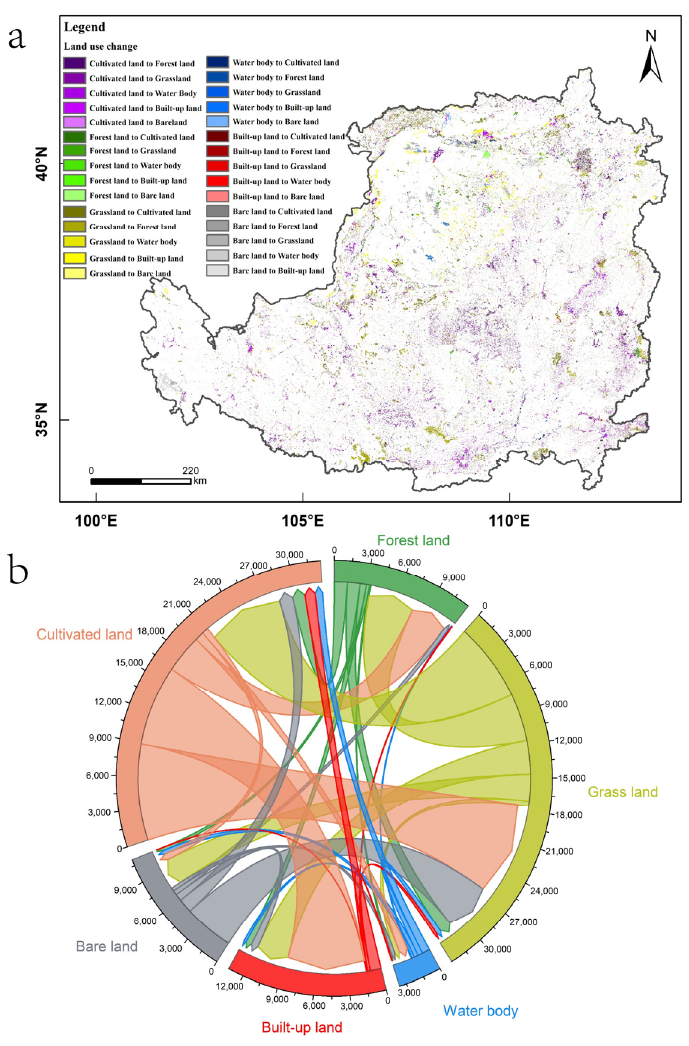
Figure 3. ( a ) Spatial patterns of land use change on the Loess Plateau during 2000–2018. ( b ) Land use quantity transfer chord diagram of the Loess Plateau during 2000–2018. The area of bare land decreased from 43,300.14 km 2 in 2000 to 39,769.35 km 2 in 2018, a total decrease of 3530.79 km 2 in 18 years, with an average annual change rate of